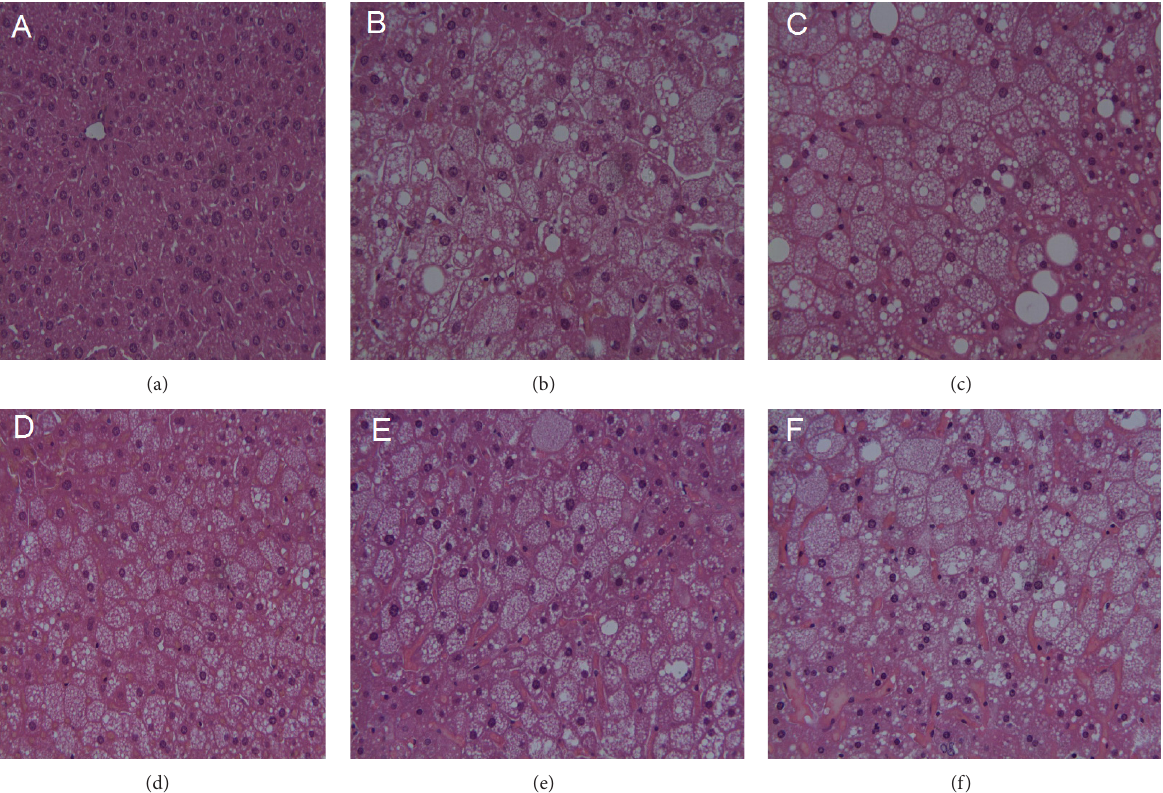
Figure 11: The pathological examination of liver tissue in db/db mice. (a) Hepatic cellular architecture from a normal mouse. (b) Hepatic cellular architecture from db/db mouse with no treatment shows ballooning degeneration and fatty degeneration of hepatocytes. (c) Microscopic view of degenerated hepatocytes from metformin-treated db/db mouse. (d), (e), and (f) Alleviation of hepatocytes degeneration from pancreatic islet from db/db mouse treated with TNTL at the dose of 3.6 g, 1.8 and 0.9 g/kg b.w., respectively.